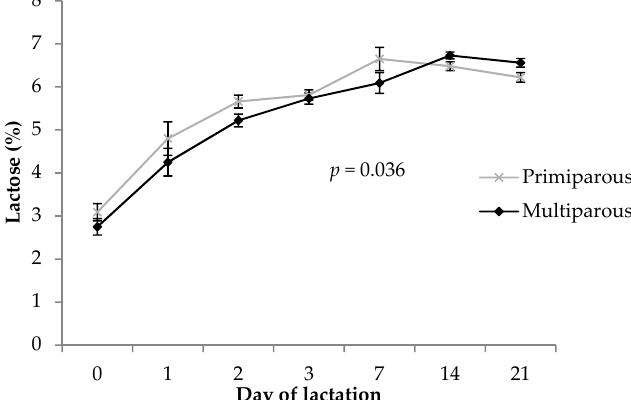
Figure 3. Comparison of total lactose concentration (%) in colostrum and milk between primiparous and multiparous sows. The p- value stated is the effect of the parity by timepoint interaction. Error bars represent the standard error of the mean (± SEM).